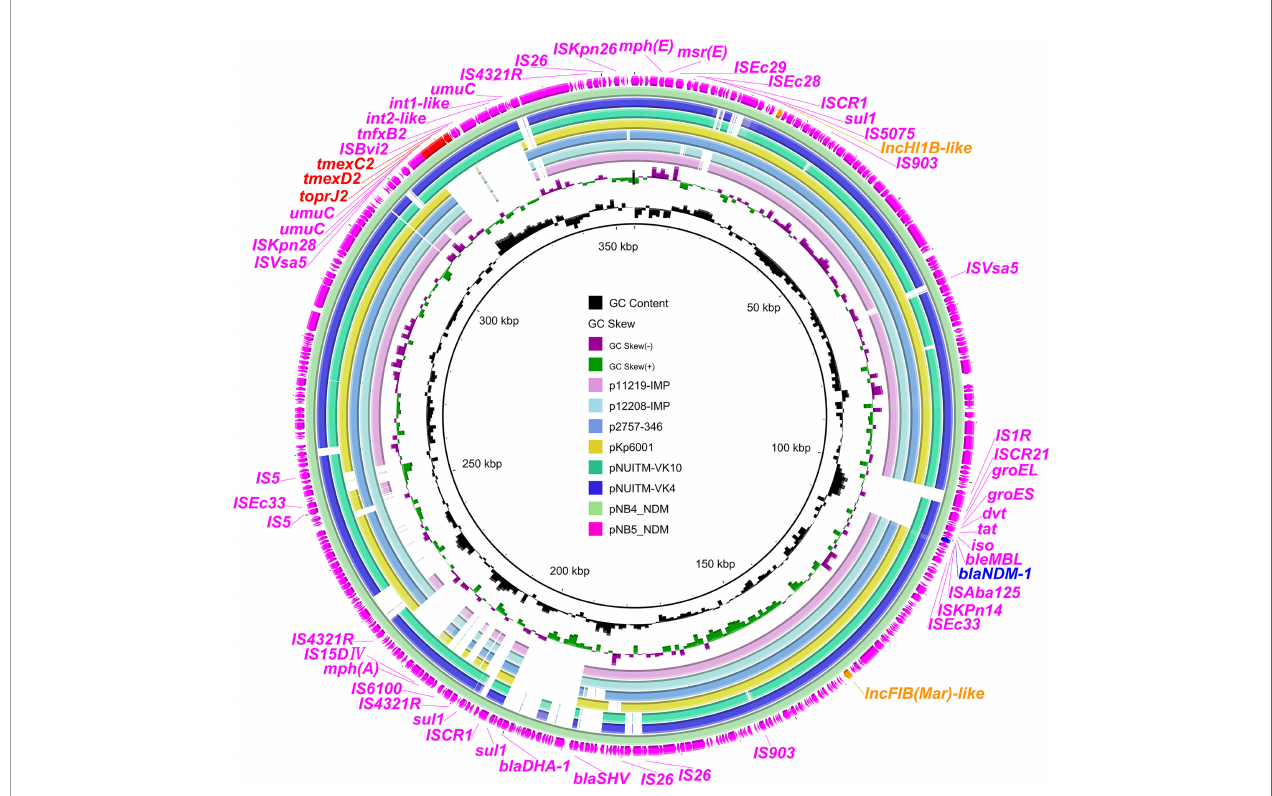
FIGURE 1 | Comparison analysis between tmexCD2 - toprJ2 -bearing plasmids and other similar plasmids. The two external rings represent the structures of pNB5_NDM (pink) and pNB4_NDM (aqua). Other similar plasmids were pNUITM-VK4 (GenBank accession no. AP025165.1), pNUITM-VK10 (GenBank accession no. AP025166.1), pKp6001 (GenBank accession no. CP082291.1), p2757-346 (GenBank accession no. CP060810.1), p12208-IMP (GenBank accession no. MF344562.1), and p11219-IMP (GenBank accession no. MF344561.1). The fi gure was constructed using